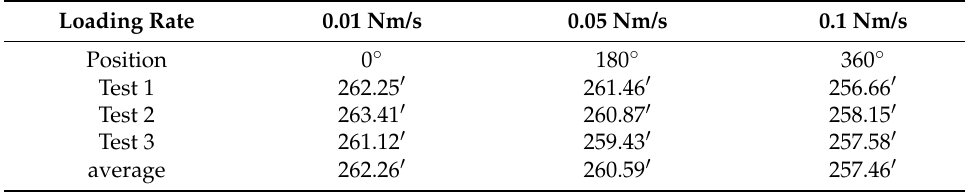
Table 11. Experiment results of δ g .